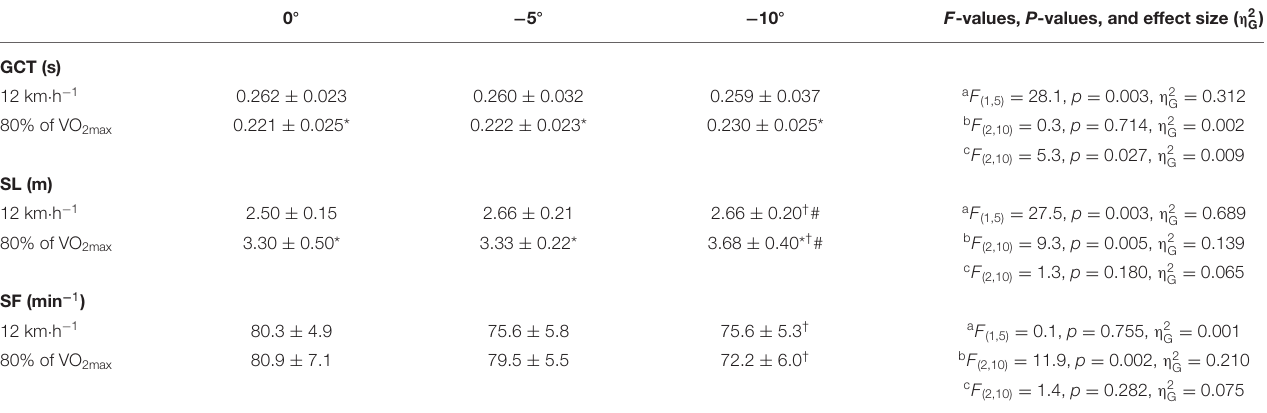
TABLE 1 | Spatiotemporal variables on level and downhill running ( n =